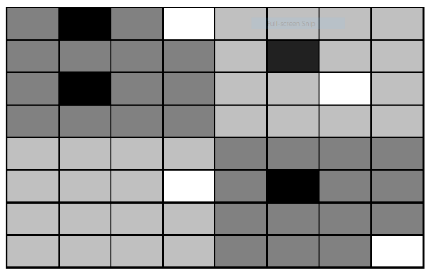
Figure 2. A puzzle including white cells assigned to different subareas in the board.